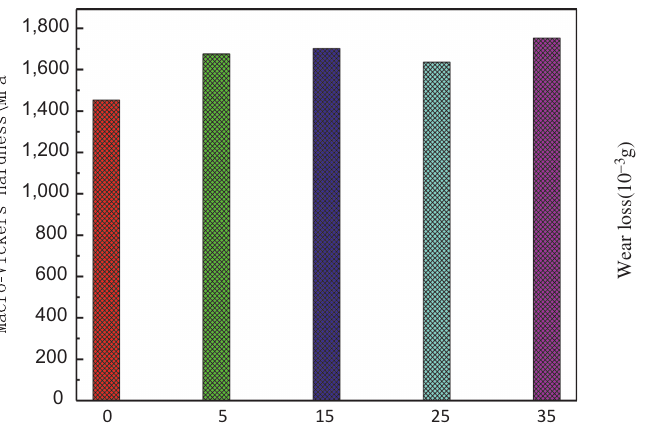
Figure 5: Evolution of wear loss of hypoeutectic Al – 10Si alloy with number of